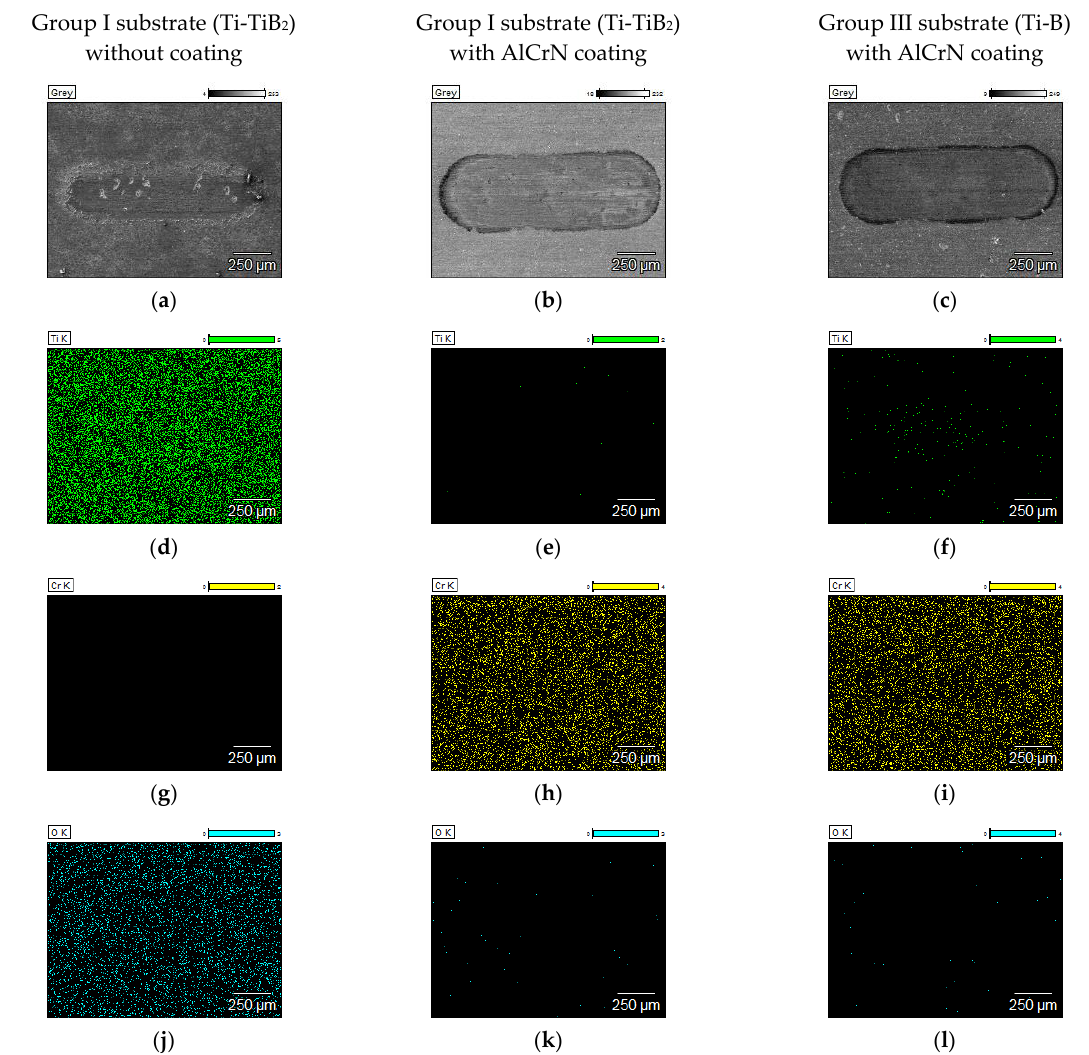
Figure 13. The EDS maps covering the wear tracks of the samples tested at 600 ◦ C: ( a ) SEM image, Group I without coating, ( b ) SEM image, AlCrN/Group I, ( c ) SEM image, AlCrN/Group III, ( d ) Ti map, Group I without coating, ( e ) Ti map, AlCrN/Group I, ( f ) Ti map, AlCrN/Group III, ( g ) Cr map, Group I without coating, ( h ) Cr map, AlCrN/Group I, ( i ) Cr map, AlCrN/Group III, ( j ) O map, Group I without coating, ( k ) O map, AlCrN/Group I, ( l ) O map, AlCrN/Group